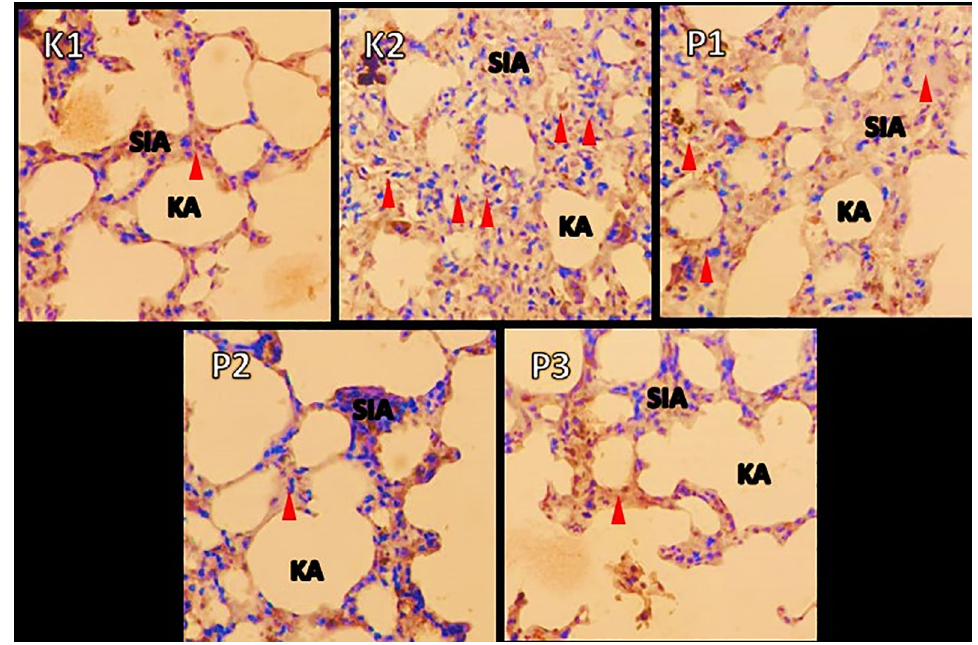
Figure 4. A picture of changes in the lung organs in the rat before and after treatment RDF extract (antioxidant exogen). Note: Red arrow = inflammatory cells; SIA = interalveolar septum, KA = alveolar